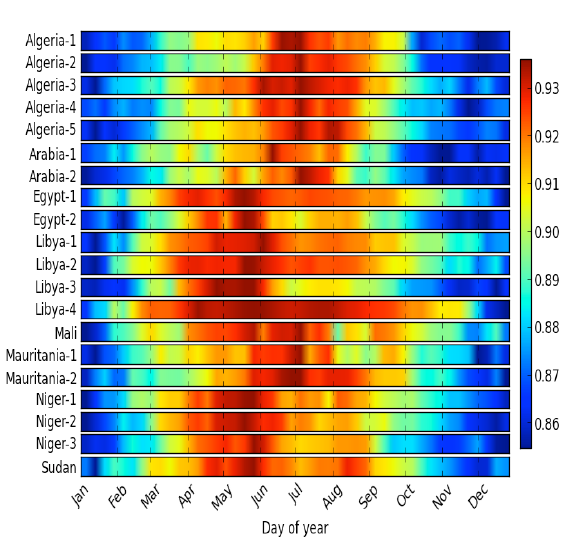
Figure 5. Isotropicity index (k iso /(k iso +k geo +k vol )) by day of year (0: totally anisotropic, 1: totally isotropic). Extracted from 13 years (2003-2015) of 8-daily MODIS-BRDF.